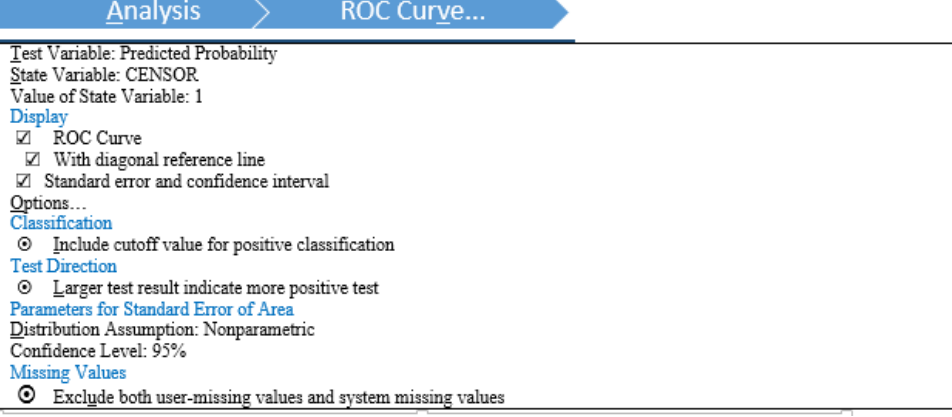
Figure 10. ROC Curve for Logistic